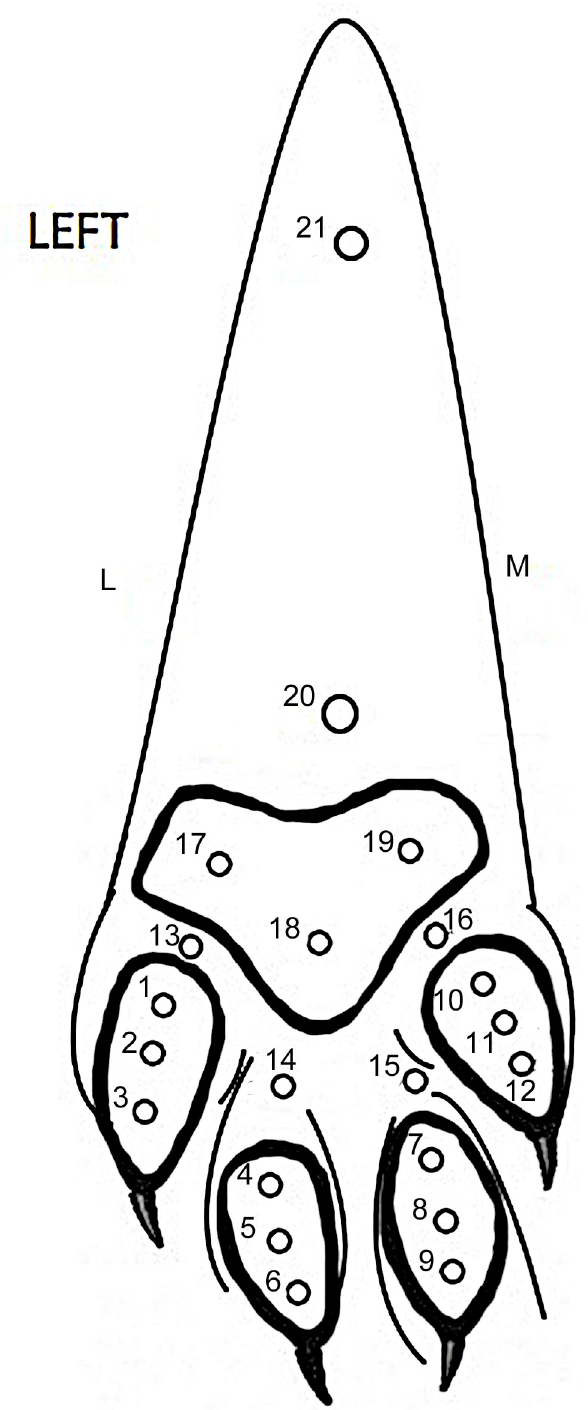
Fig 3. Diagram of left pes illustrating 21 points assessed for sensitivity by pinching with rat tooth forceps. L, lateral; M, medial.